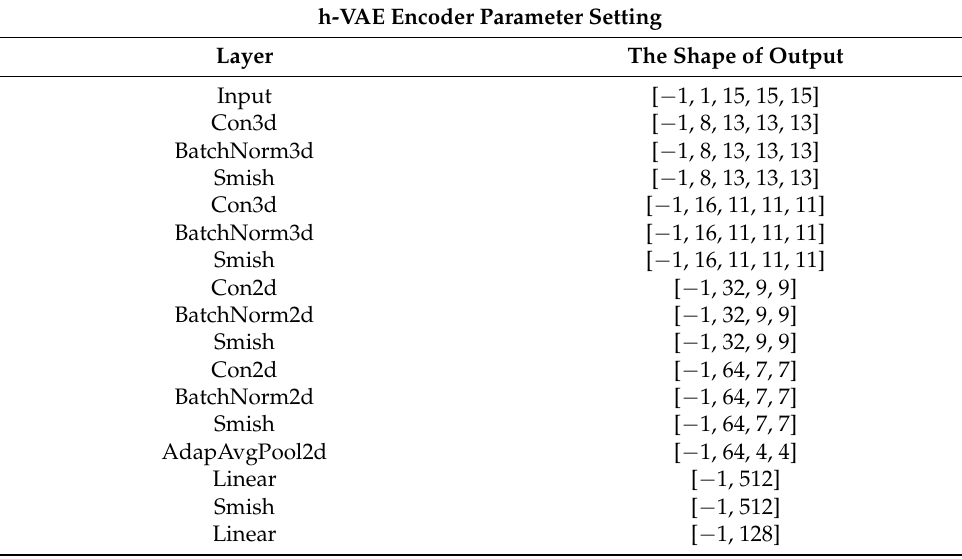
Table 6. The shape of layers in the h-VAE model for